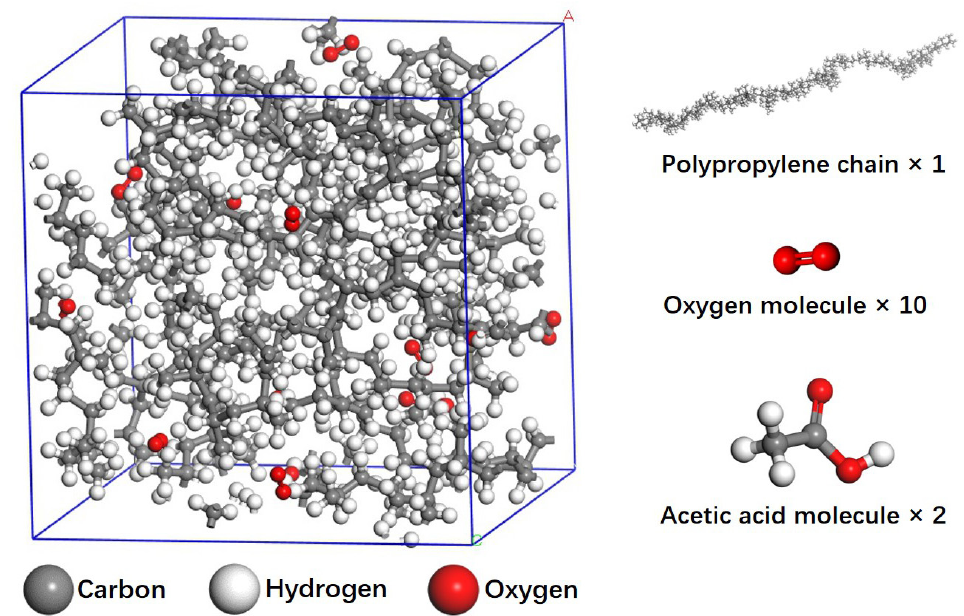
Figure 1. Configuration of PP-10O 2 -2C 2 H 4 O 2 model (1 polypropylene (PP) chain, 10 oxygen molecules, and 2 acetic acid molecules were added into a box with periodic boundary